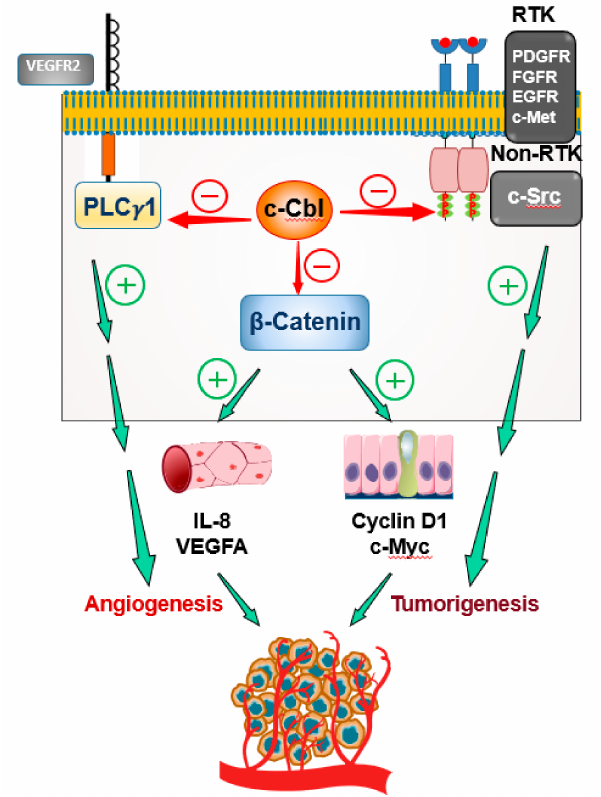
Figure 3. c-Cbl is an attractive therapeutic target for angiogenesis and tumorigenesis. In the endothelial cells of vessels supplying the tumor, Wnt activation results in secretion of pro-angiogenic cytokines IL-8 and VEGF-A that augment tumor-induced angiogenesis. In colon cancer epithelial cells, inactivating mutations in APC tumor suppressor stabilizes β -Catenin and allows its nuclear translocation. This event results in the transcription of pro-proliferative and pro-oncogenic genes such as Cylin D1 and c-Myc to augment oncogenic activity. c-Cbl, by ubiquitinating nuclear β -Catenin in endothelial cells and in colon cancer cells, suppresses the growth of blood vessles and tumors. In addition, c-Cbl suppresses these processes by downregulating other pathways such VEGF signaling (PLC γ 1) and mitogenic signaling (RTK and